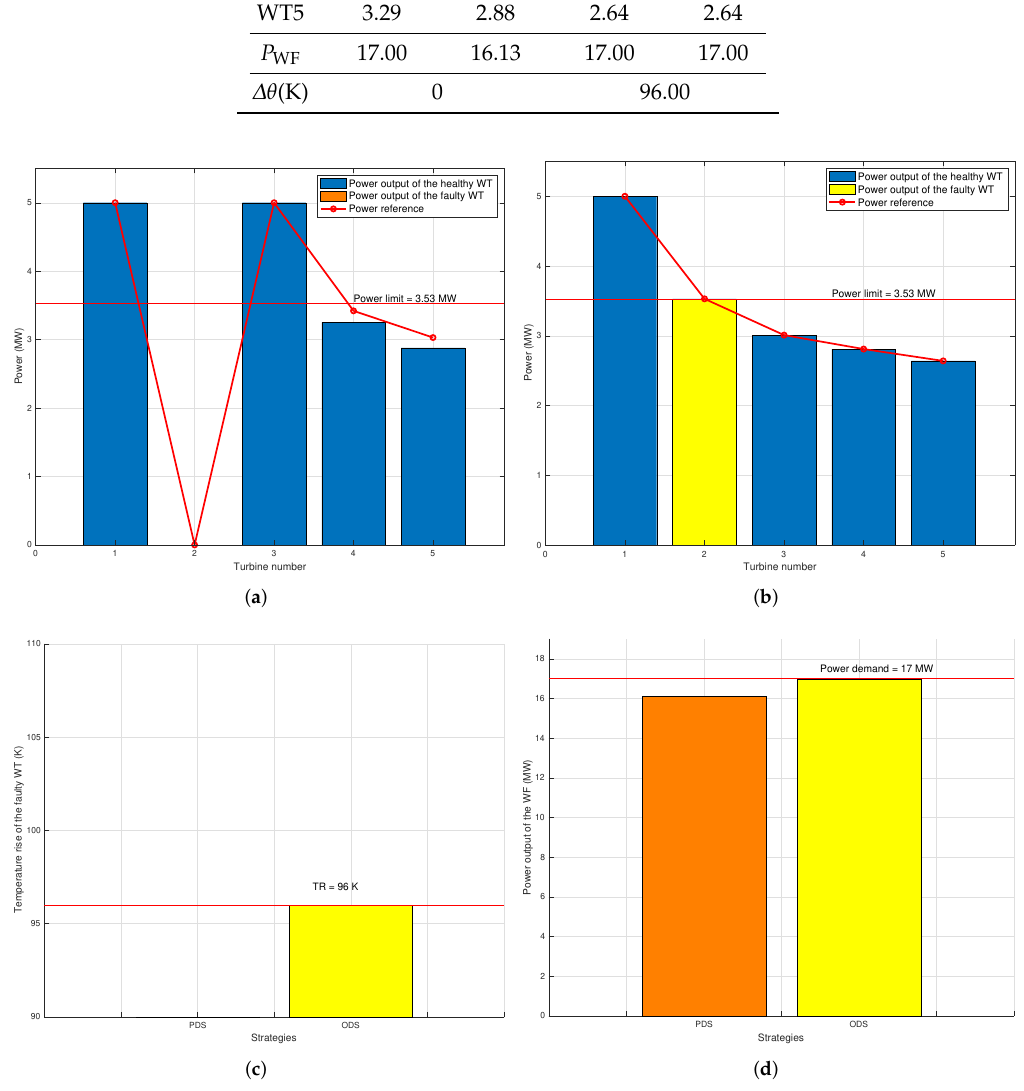
Figure 14. Comparison of power and temperature rise in Case 3, M2: ( a ) power reference and power output in PDS; ( b ) power reference and power output in ODS; ( c ) temperature rises of the faulty WT in PDS and ODS; ( d ) power output of the